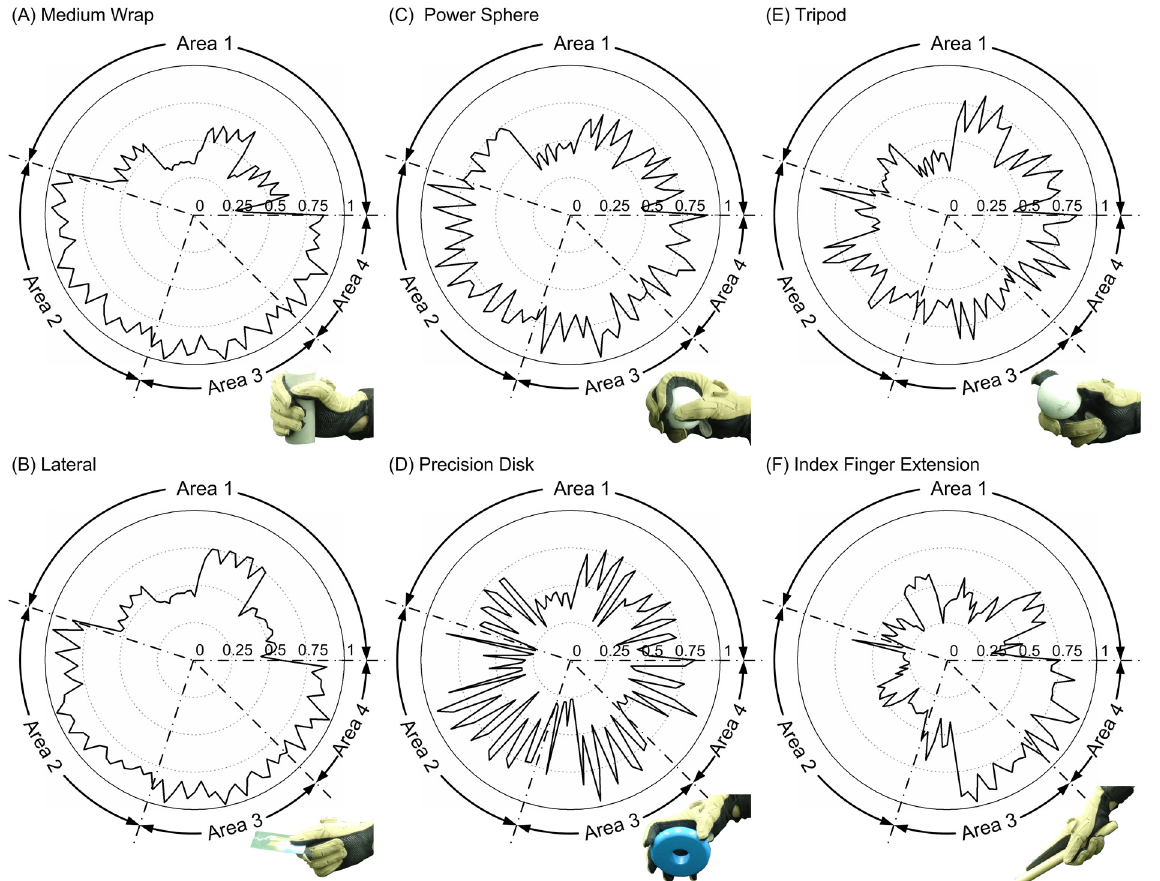
Fig 3. Movement-coordinated relationships between joints of the human hand in each type of task. There are 16×(16 – 1)/2 = 120 variables of movement-coordinated relationships between every two of the 16 joints recorded in the movement dataset, and they are distributed along the ring circle in the radar chart. Area 1 represents the coordinated relationships regarding the joints of thumb and contains the internal relationships between the joints of the thumb and the external relationships between the joints of thumb and the other four fingers. Similarly, area 2 represents the coordinated relationships regarding o the joints of the index finger excluding the joints of the thumb, and so on. The coordinated relationships between all joints of the ring and little fingers are represented in area 4 of the chart. The amplitudes of the coordinated relationships are averaged across all subjects. The six tasks are chosen to represent the features of all